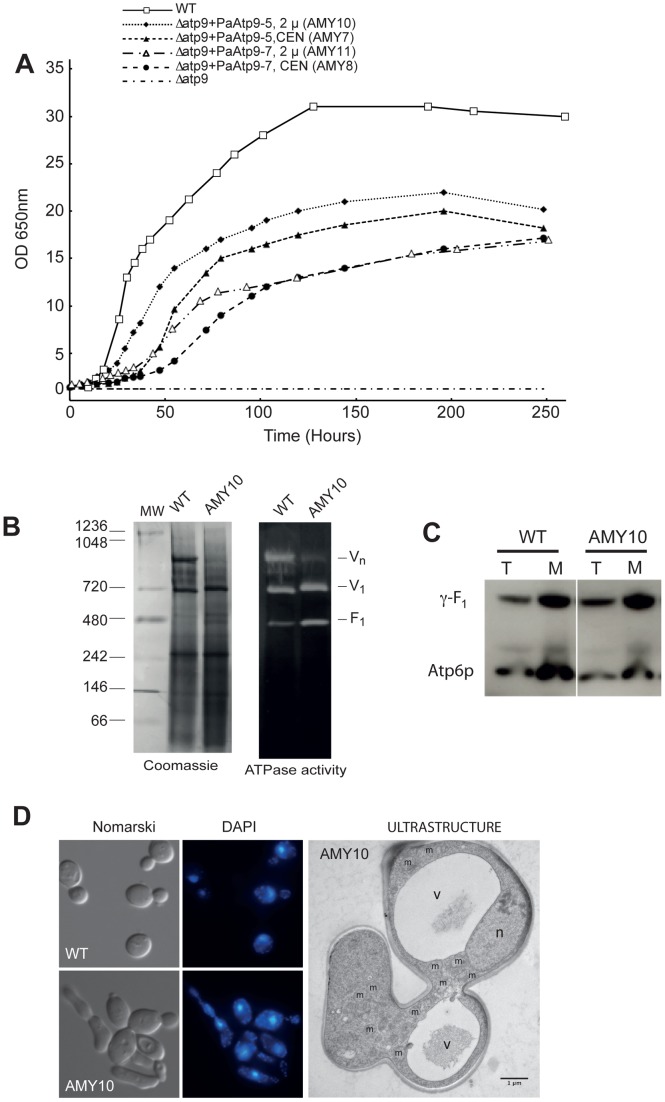
The P. anserina Atp9 genes restore respiratory competence in Δatp9 yeast.The Δatp9 strain was transformed with CEN or 2 µ plasmids harbouring PaAtp9-7 or PaAtp9-5, yielding strains AMY8 (Δatp9+PaAtp9-7, CEN), AMY11 (Δatp9+PaAtp9-7, 2 µ), AMY7 (Δatp9+PaAtp9-5, CEN), and AMY10 (Δatp9+PaAtp9-5, 2 µ). A) Growth curves of all strains in rich glycerol/ethanol medium at 28°C (subsequent panels use the same growth conditions). B) ATP synthase levels in WT and AMY10 revealed by separation of isolated mitochondria by BN-PAGE. The ATP synthase complexes (V1, monomer; Vn, oligomers) and free F1 were revealed in-gel by their ATPase activity (right). C) Total cellular (T) and mitochondrial (M) protein extracts were prepared from WT, AMY7 and AMY10 grown in YPEG. Samples (20 µg) were separated by SDS-PAGE and probed with antibodies against yeast Atp6p and γ-F1. D) Differential interference contrast microscopy (left, ‘Nomarski’) and DAPI staining/fluorescence microscopy (middle) of WT and AMY10 cells. Right (‘Ultrastructure’) are electron micrographs of AMY10 cells (80 nm-thin sections). V, vacuole; n, nucleus; m, mitochondria.